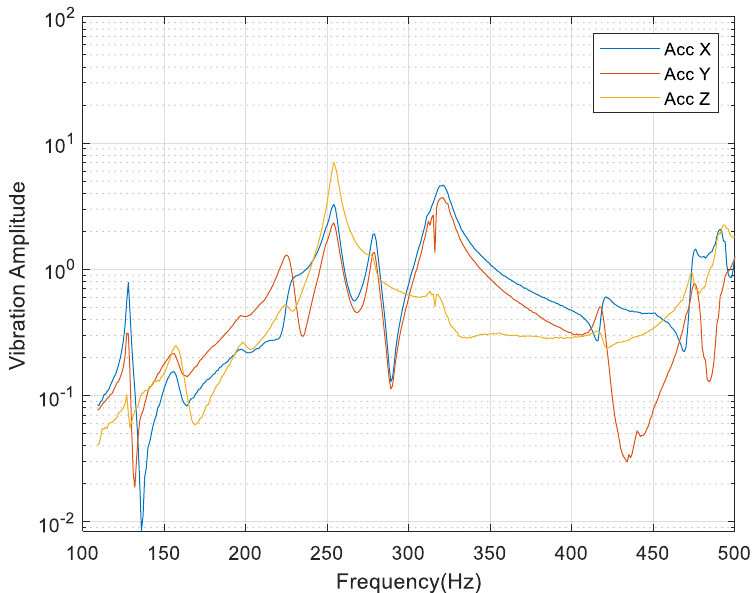
Figure 10. Frequency Response Function (FRF) plot of the tri-directional force measurement calibration setup.